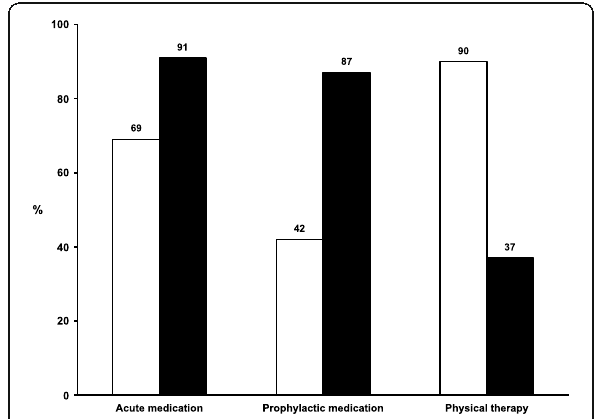
Fig. 3 Percentage of respondents who would use different types of treatments for patients with chronic tension-type headache (white bars) and frequent episodic migraine (1 – 2 attacks per week) (black